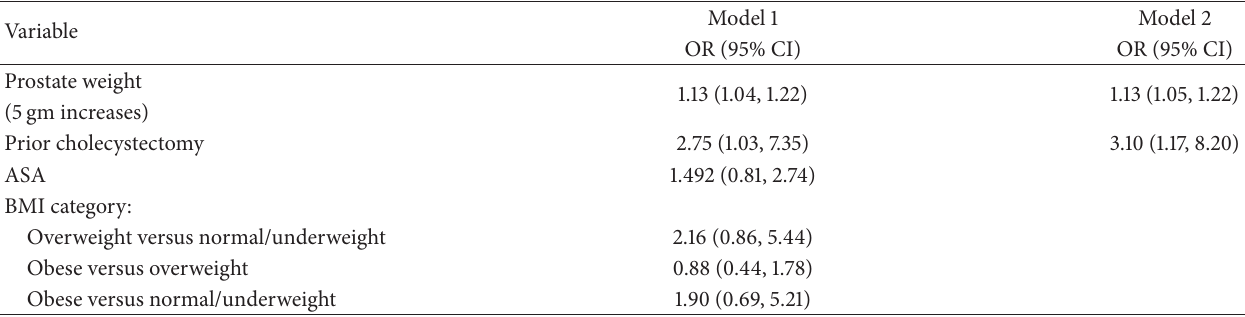
Table 4: Differences in incisional hernia rates as measured by odds ratios from logistic regression